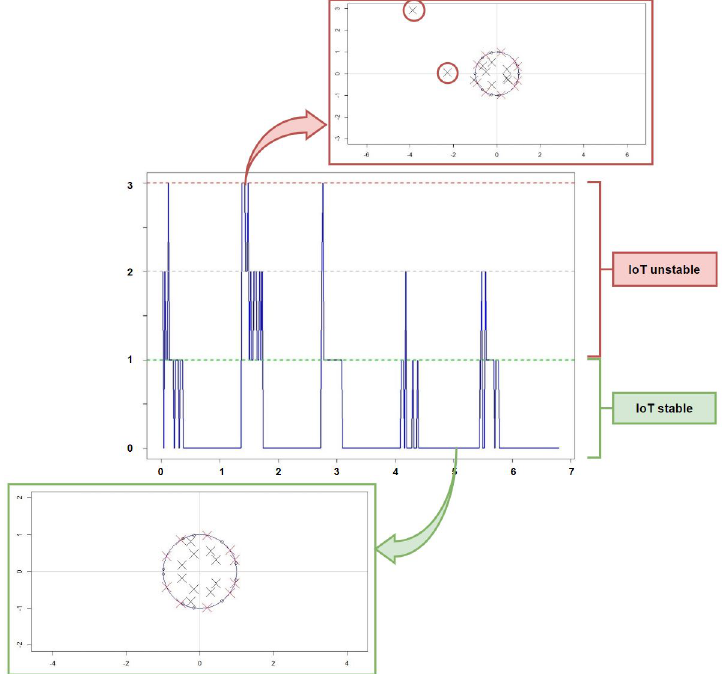
Figure 3. The stability of the IoT system in the case study. In the figure one can see the zones of stability (green) and instability (red). During the experiment, 4 disturbances have been introduced in the temperature of the IoT system. There has also been an additional period of instability when the IoT network was first implemented in the smart building and the control algorithm had to reach the equilibrium of the IoT system. The stability criterion (i.e., absolute value of the eigenvalues of P of this case study) provides its output in two different colors: in green when the system is stable; in red when the system is